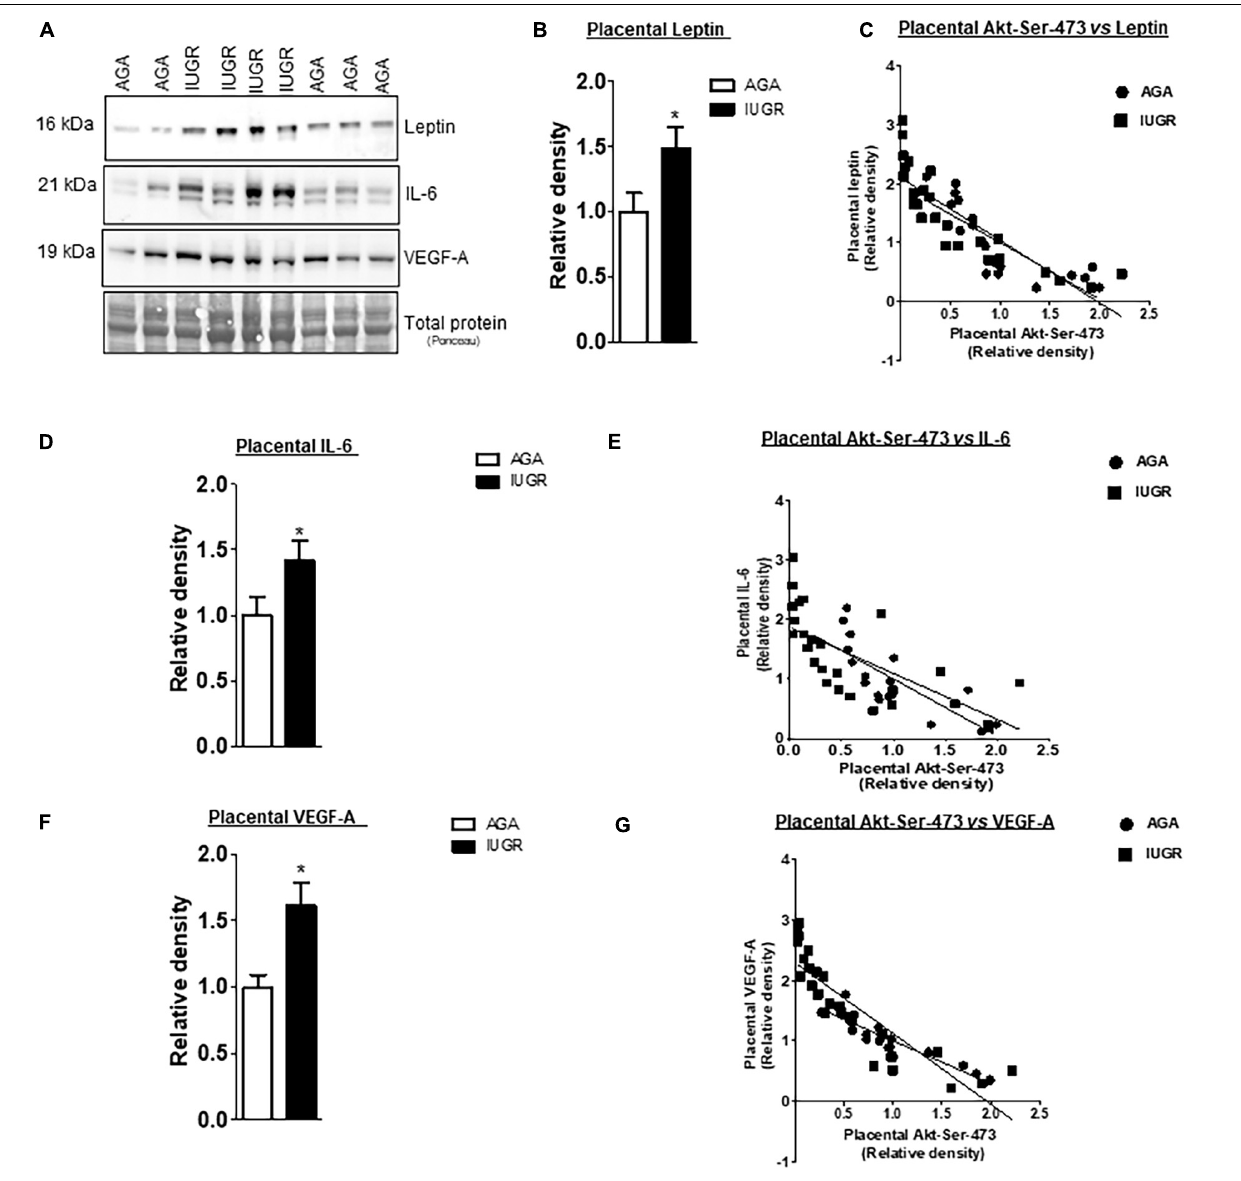
FIGURE 5 | Correlation between placental mTORC2 functional readouts and the protein expression of leptin, VEGF-A and IL-6. (A) Representative western blots of leptin, IL-6 and VEGF-A expression in homogenates of AGA and IUGR placentas. Equal loading was performed. (B,D,F) Relative expression of leptin, VEGF-A and IL-6 in homogenates of AGA and IUGR placentas. * P < 0.05 vs. AGA, unpaired Student’s t -test. (C,E,G) Correlation between placental mTORC2 functional readouts AKT Ser - 473 and leptin, VEGF-A and IL-6 expression. r = Pearson correlation coefficient, n = AGA, 19; IUGR, 25. Pearson correlation analysis was used to